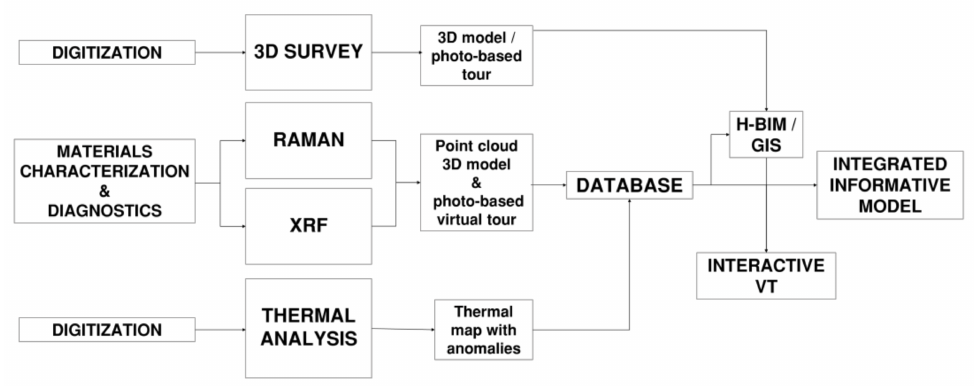
Figure 5. General